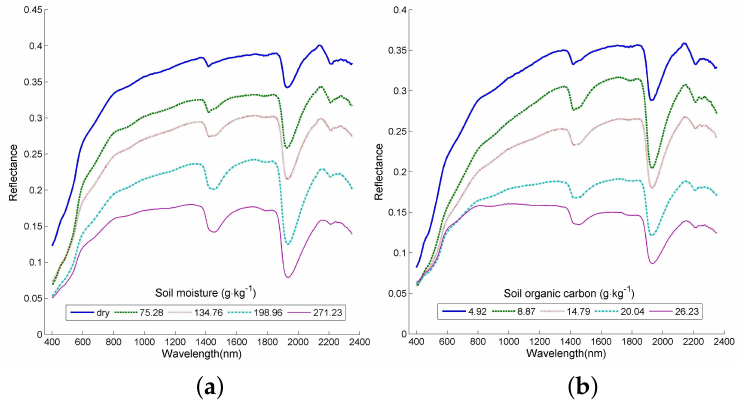
Figure 3. Spectral reflectance curves of soil samples with two single variable conditions measured with visible and near-infrared reflectance (VIS-NIR) spectroscopy: the effect of moisture on the reflectance spectra for a soil with 16.86 g · kg − 1 soil organic carbon ( a ), reflectance as a function of soil organic carbon with 150 g · kg − 1 soil moisture content ( b